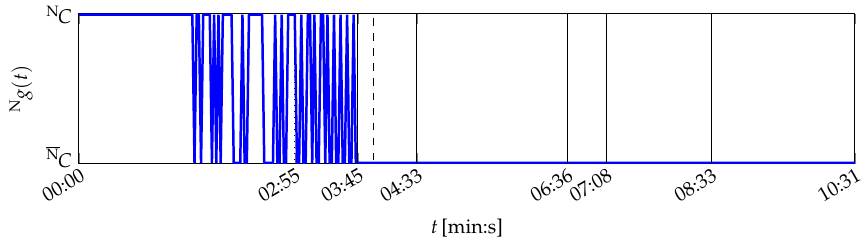
Figure 10. System health evaluation over time during manipulated operation of the printing unit demonstrator (PU manip ) by one-class